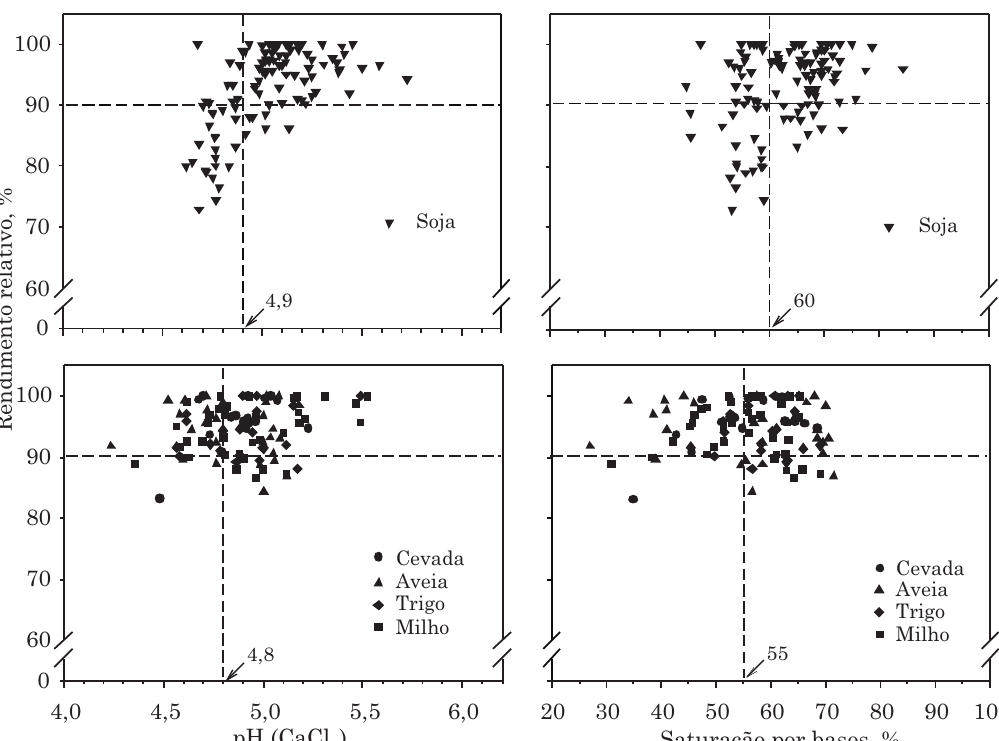
Figura 3. Relação entre o rendimento relativo de grãos e os indicadores de acidez, pH (CaCl 2 ) e saturação por bases, na camada de 0-0,20 m de solos, em plantio direto na região Centro-Sul do